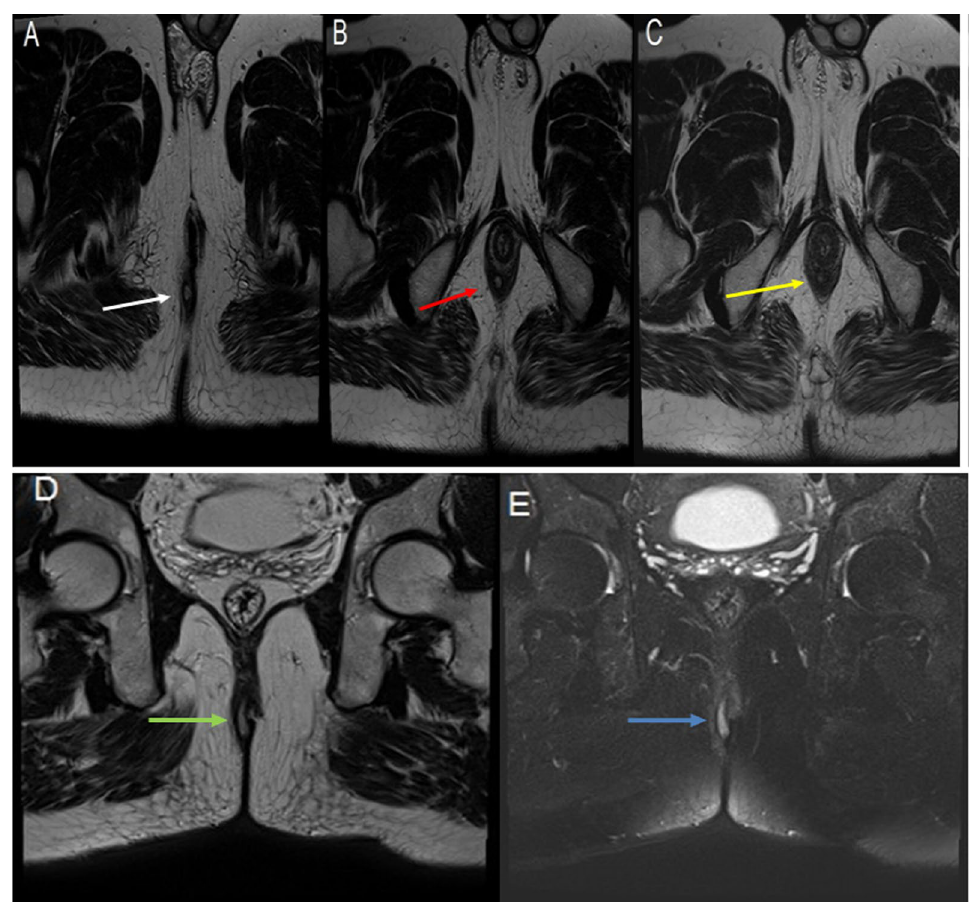
Fig. 4 A 66-year-old male patient who presented with right perianal discharge. MRI examination after local injection of US gel through the fistulous tract revealed through axial T2 images ( A – C ): A External cutaneous opening of the fistulous tract (white arrow). B A non-branching simple tract at the right intersphincteric space (red arrow). C Internal mucosal opening connected to the anal canal at six o’clock (yellow arrow). Coronal T2 images showed: D the course of the linear intersphincteric tract (green arrow). E A coronal STIR image showed hyper-intense signal of the right intersphincteric tract (blue arrow). The final diagnosis was a right, grade I, intersphincteric